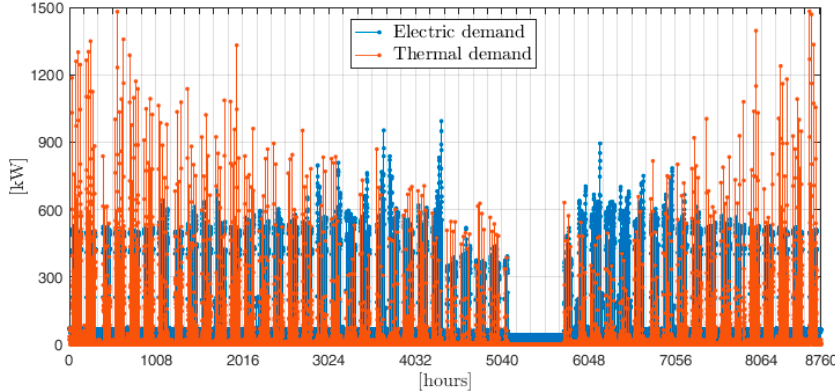
Figure 4. Energy load demand of the case study.